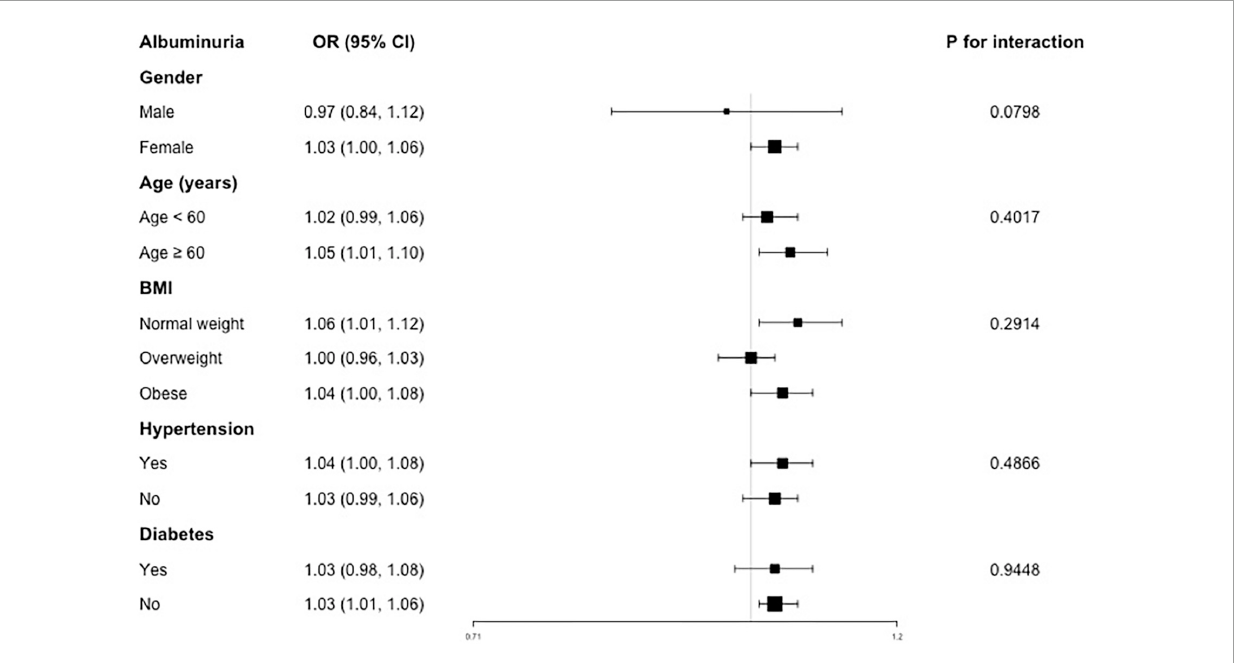
FIGURE2 Subgroup analysis for the association between VAI and